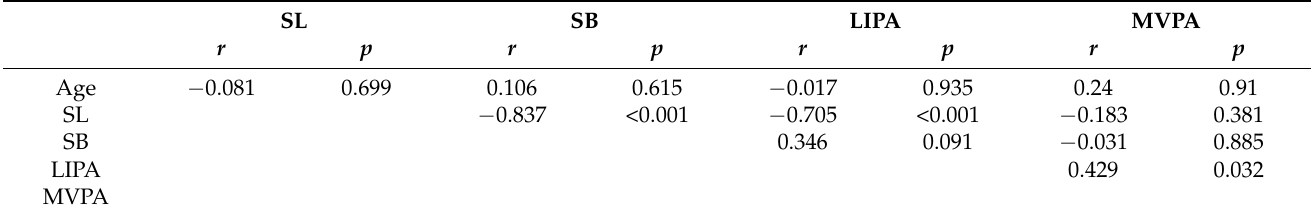
Figure 1. Percentage of time spent in sleep, sedentary behavior, and total physical activity (low- intensity physical activity + moderate vigorous physical activity) (outer ring). Proportion of time spent in each intensity of physical activity (inner ring; darker color indicates longer duration). The relationships among the physical activity intensity levels are shown in Table 2, and Figure 2 provides the scatter plots of the relationships between SL and SB and be- tween SL and LIPA. The correlation between SL and SB was very strong (r = − 0.837, p < 0.001, Figure 2a). The correlation between SL and LIPA was moderately strong (r = − 0.705, p < 0.001, Figure 2b). The correlation between LIPA and MVPA (r = 0.429, p = 0.032) was fair. The patients ’ SB and LIPA showed a non-significant association (r = 0.346, p = 0.091). The relationship between each physical activity intensity’s time volume and physical function is shown in Table 3. A fair correlation was found between the patients’ SB and Table 2. Correlation between age and each physical activity intensity ( n = their scores on the BBS (r = − 0.432, p = 0.031). Although not significantly associated, SL and the BBS (r = 0.354, p = 0.083) were observed to be inversely related to SB and the BBS